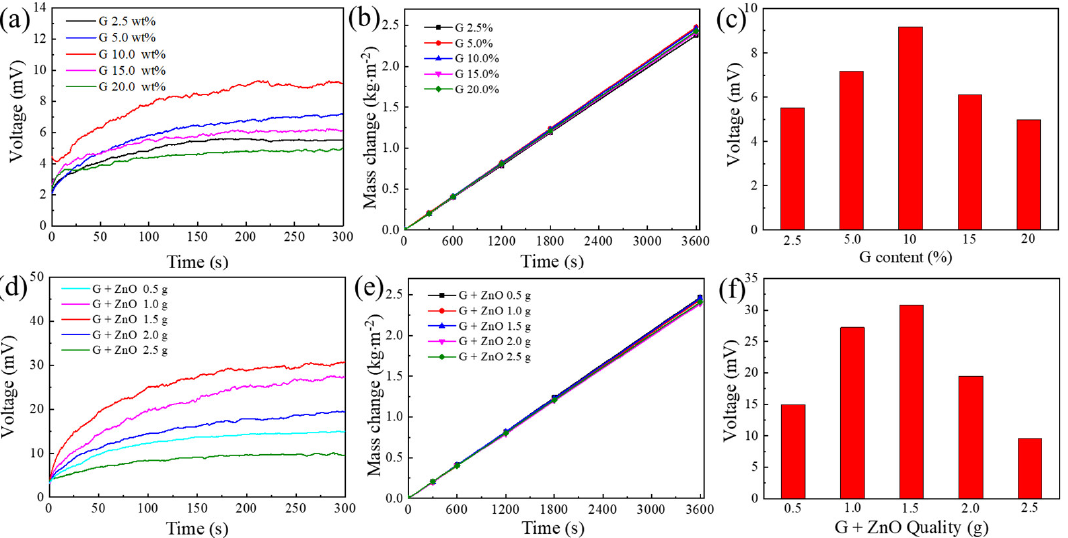
Figure 4. ( a ) Open−circuit voltage; ( b ) Evaporation mass change; ( c ) Maximum open−circuit voltage of the device for changing the proportion of graphene in the thermoelectric layers. ( d ) Open−circuit voltage; ( e ) Evaporation mass change; ( f ) Maximum open−circuit voltage of the device for changing the total amount of graphene and ZnO in the thermoelectric layers.